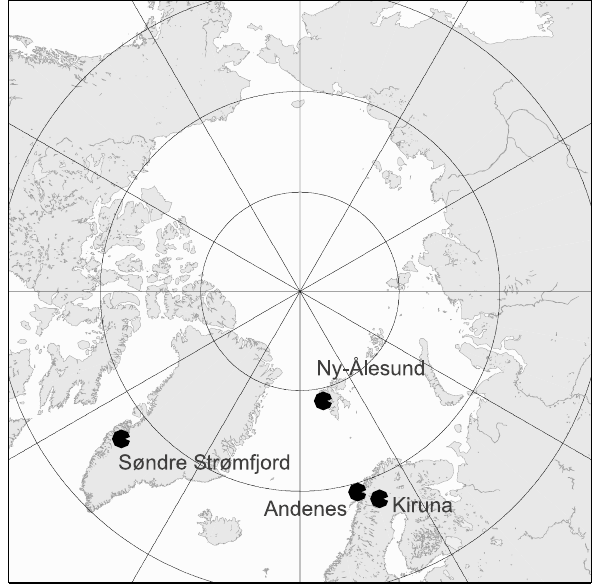
Fig. 1. Map of the Arctic region with the lidar stations contributing to the observations. Circles are at 10 ◦ latitude